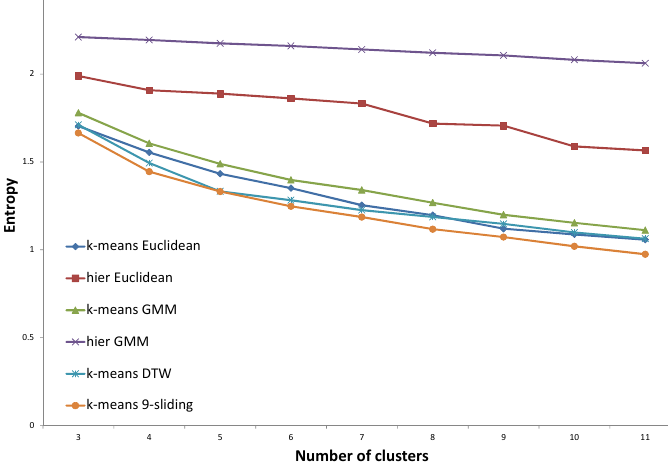
Figure 7. Entropy results for the southern part of Gyeonggi Province according to expert